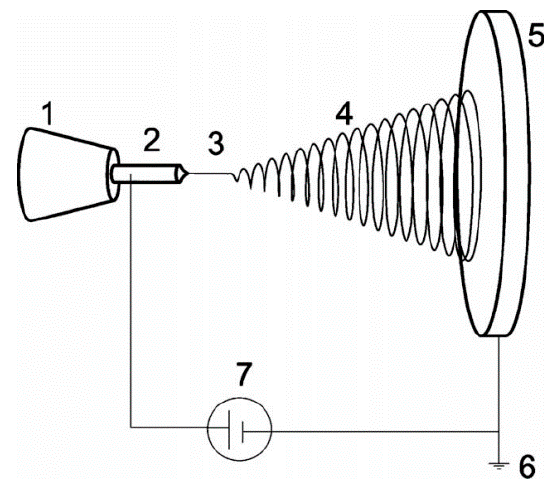
Figure 5. Schematic representation of electrospinning system: ( 1 ) syringe and metering pump, ( 2 ) needle/capillary acting as the electrode, ( 3 ) stable part of the jet, ( 4 ) whipping/coiling zone, ( 5 ) collector, ( 6 ) ground, and ( 7 ) high voltage supply. Reproduced from [112] with permission.